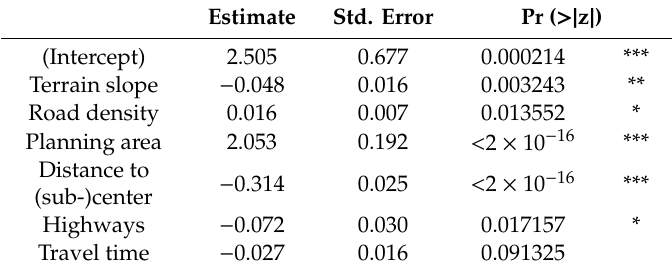
Table 4. Fixed e ff ects for the spatial variables associated with urbanization in Xi’an.